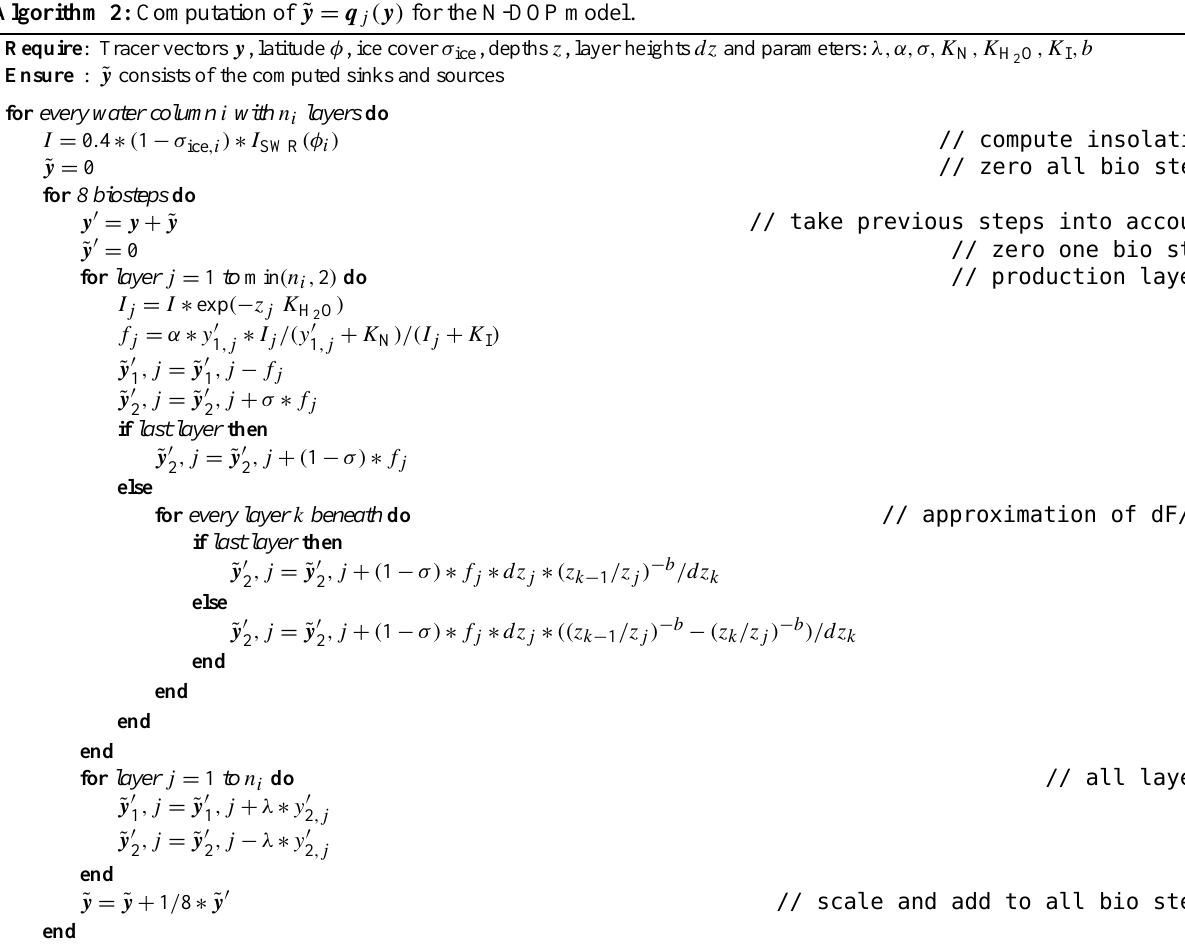
Algorithm 2: Computation of ˜ y = q j ( y ) for the N-DOP